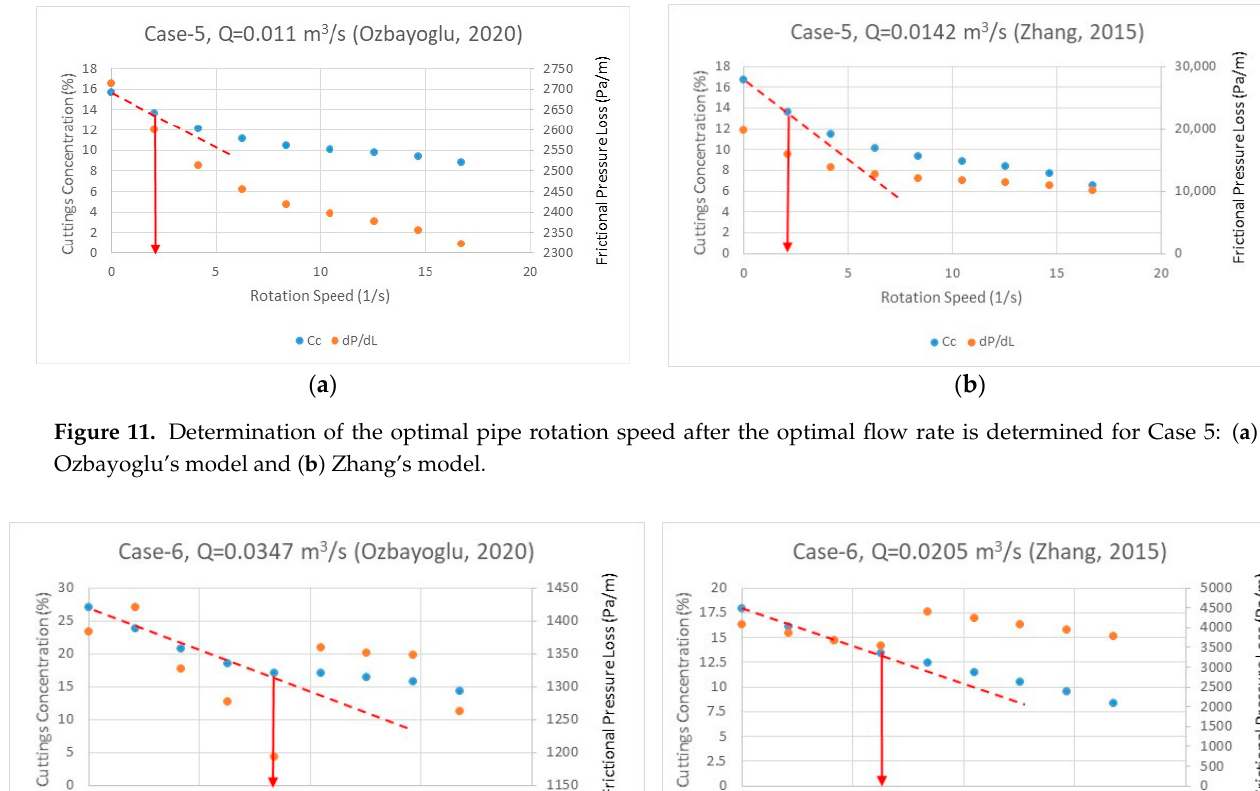
Figure 10. Determination of the optimal pipe rotation speed after the optimal flow rate is determined for Case 4: ( a ) Ozbayoglu’s model and ( b ) Zhang’s model.